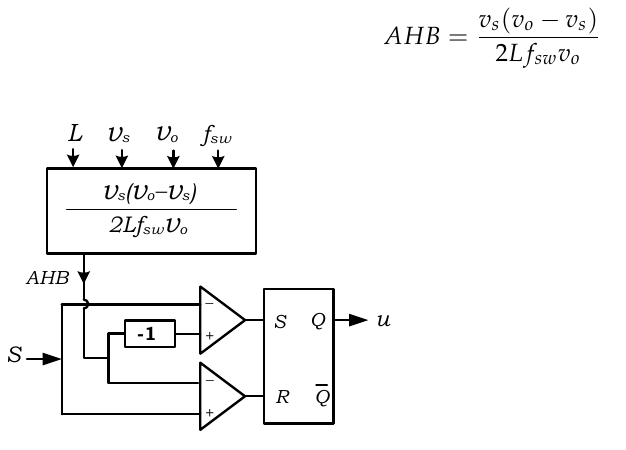
Figure 8. Adaptative hysteresis band